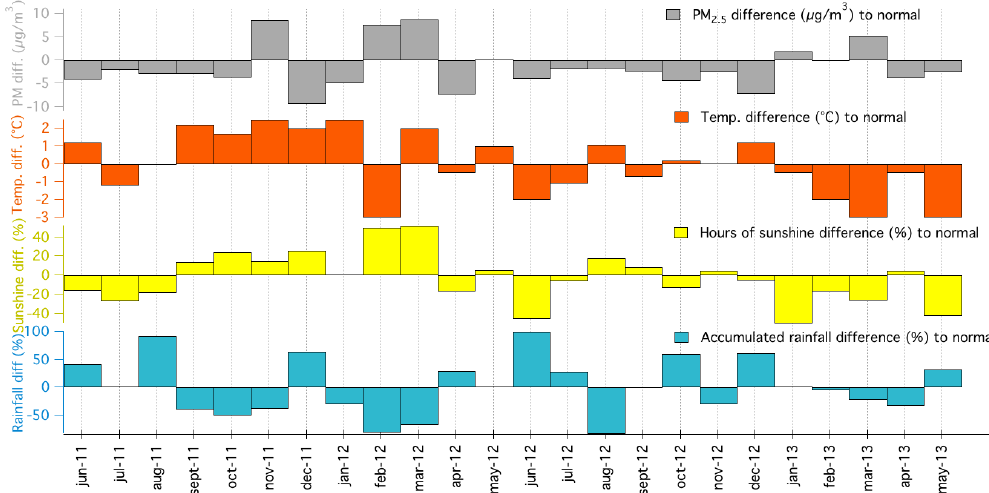
Figure 4. Comparison between observed and average PM 2 . 5 , temperature, hours of sunshine and accumulated rainfall in the region of Paris.